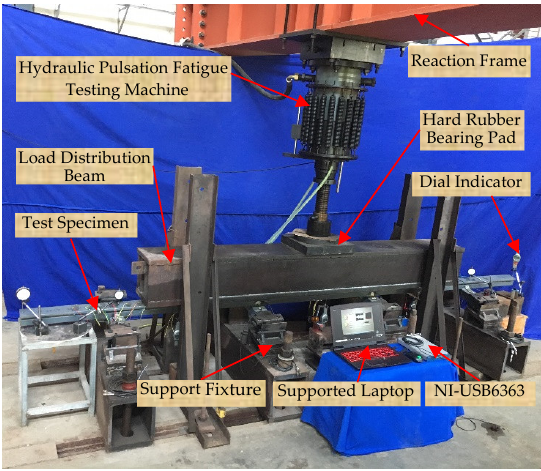
Figure 5. Photo of the experimental setup.